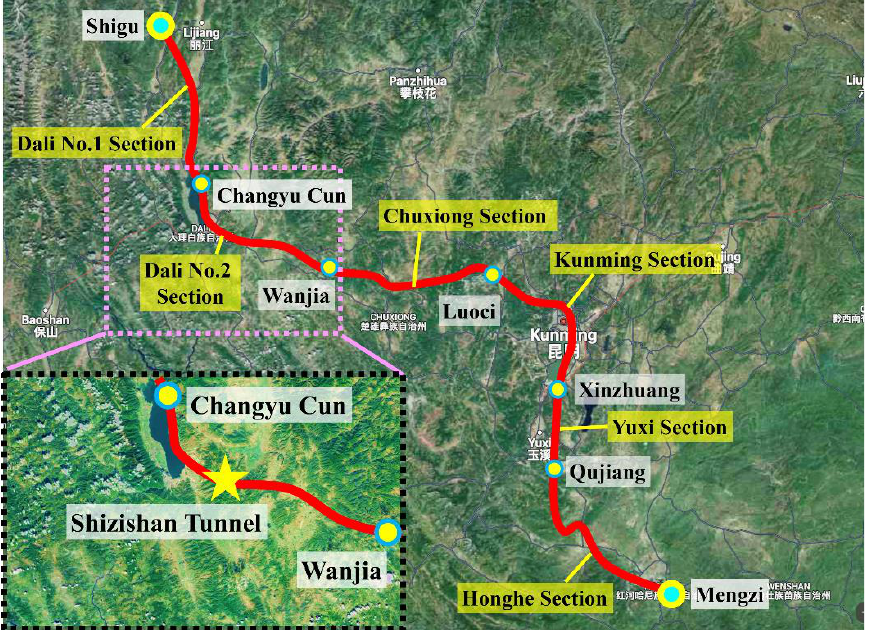
Figure 1. Schematic layout diagram of the Central Yunnan Water Diversion Project (Dali Section II).